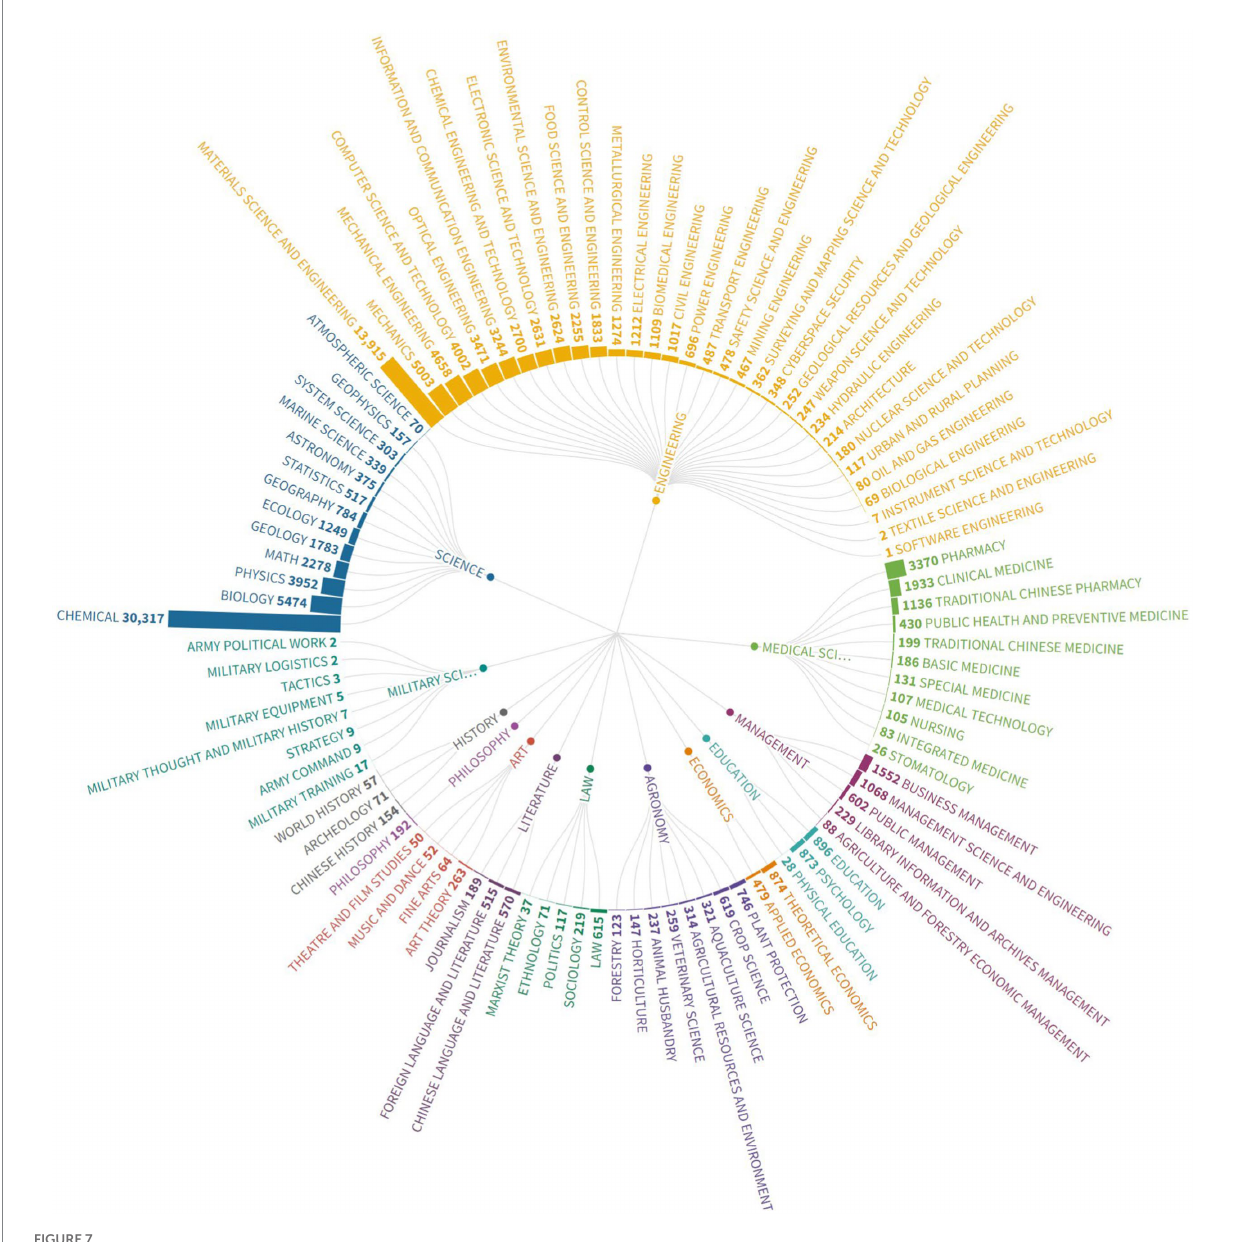
FIGURE 7 The major distribution of the posters on